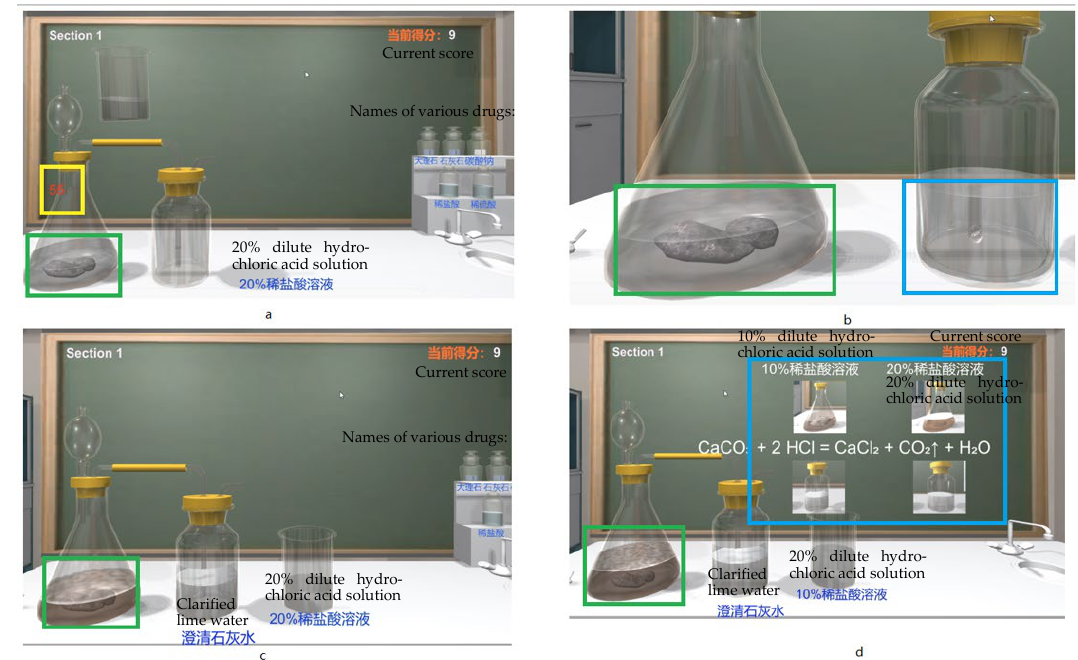
Figure 10. Limestone and dilute hydrochloric acid experiment scene 5. ( a ). Dumping quantification interface. ( b ). Experimental phenomenon interface 1. ( c ). Experimental phenomenon interface 1. ( d ). Screenshot saving interface of experimental phenomena.